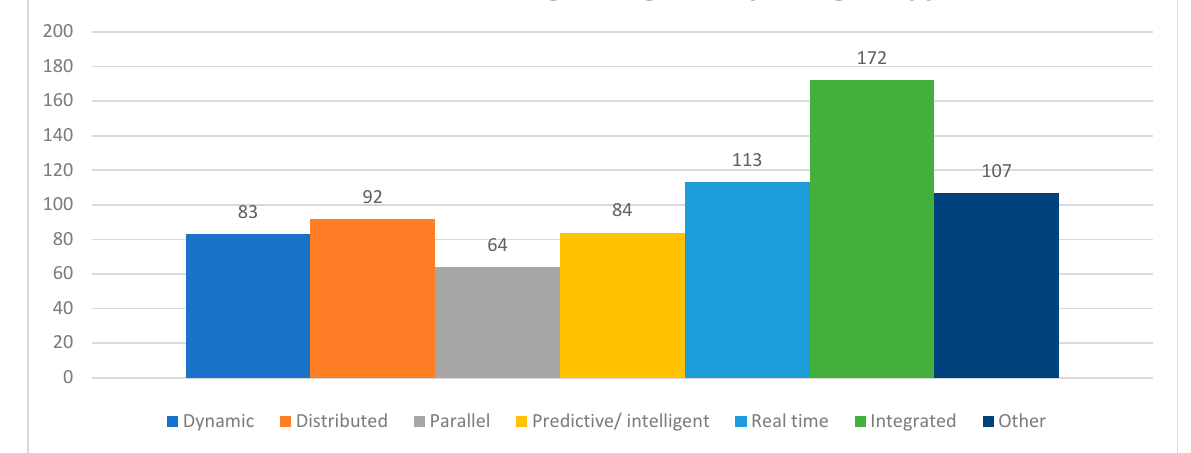
Figure 2. Total amount of publications about management paradigms from 2011 to 2021.